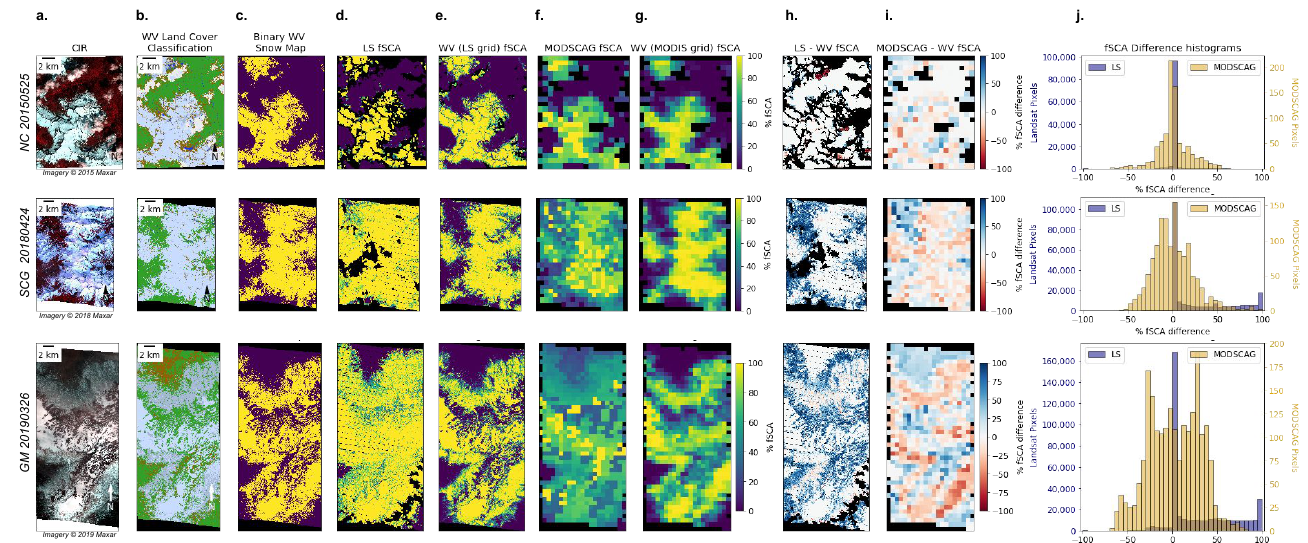
Figure 7. Selected snow classification comparison results for the North Cascades site (top row— 20 May 2015; middle row—24 April 2018) and Grand Mesa site (bottom row—26 March 2019). ( a ) WorldView color-infrared context image, ( b ) land cover classification map and ( c ) binary snow cover map, ( d ) Landsat fractional snow-covered area (fSCA), ( e ) WV fSCA for Landsat grid, ( f ) MODSCAG fSCA, and ( g ) WV fSCA for MODIS grid. Difference maps of fSCA values for ( h ) WV fSCA were subtracted from Landsat fSCA in Landsat grid, and ( i ) WV fSCA was subtracted from MODSCAG fSCA in MODIS grid with ( j ) corresponding histograms. Missing data shown in black for all